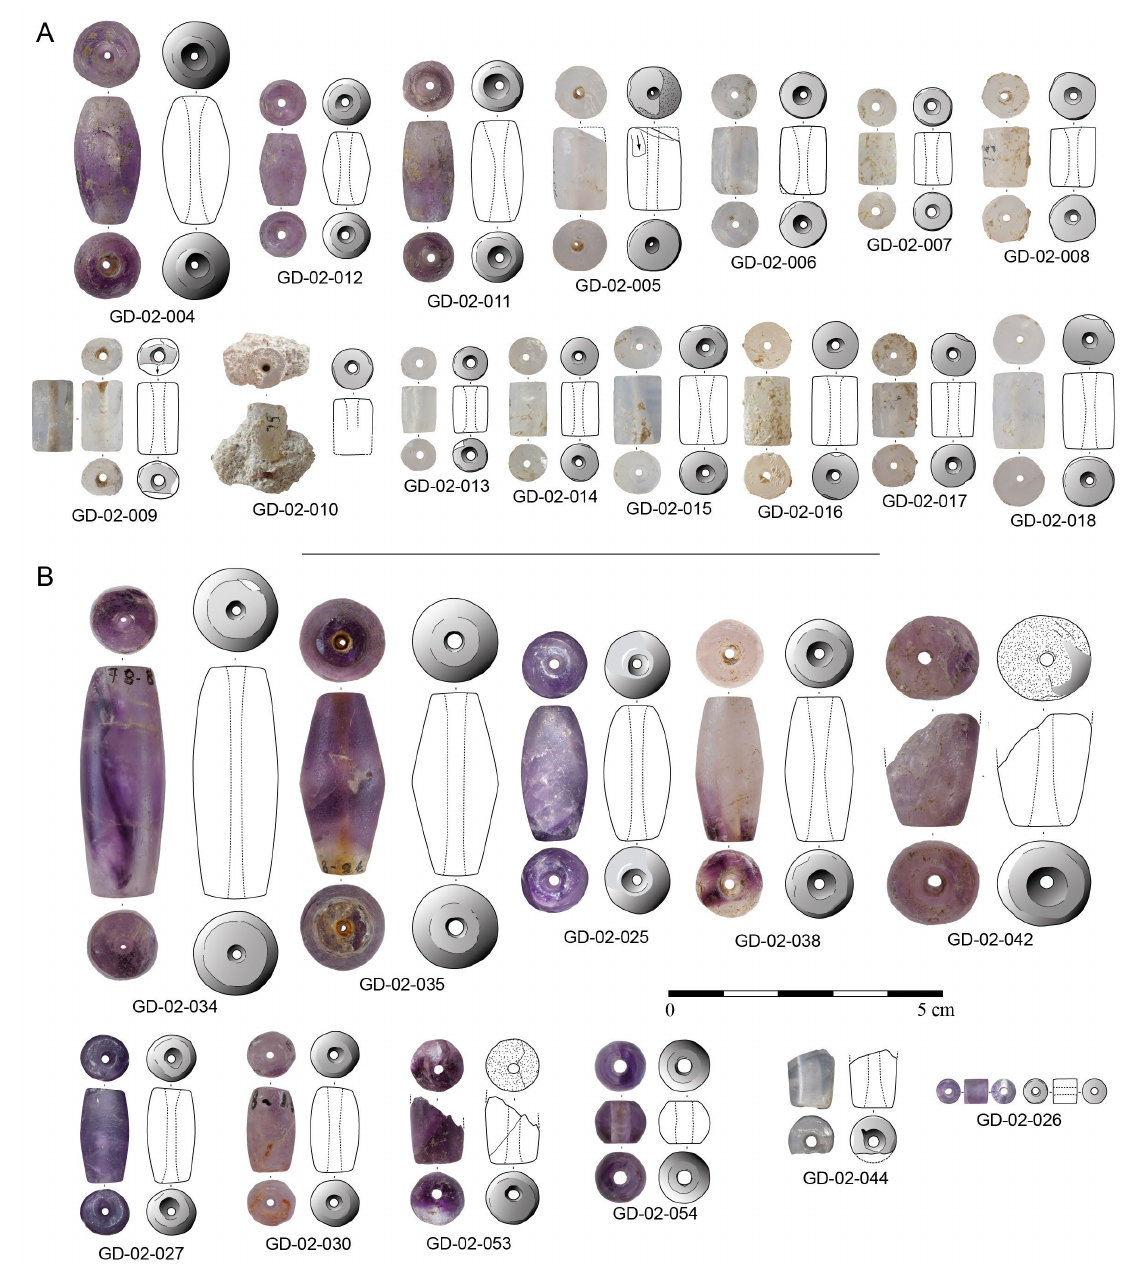
Figure 3: Photographs and drawings of beads from the collar (A) and the other parts of Morel (GD-02) site (B),